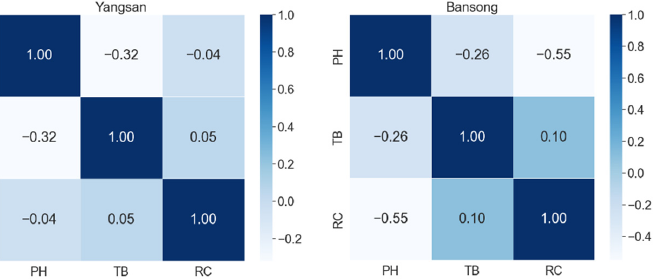
Figure 6. Spearman correlation coefficients for drinking water quality in the Nakdong River basin.